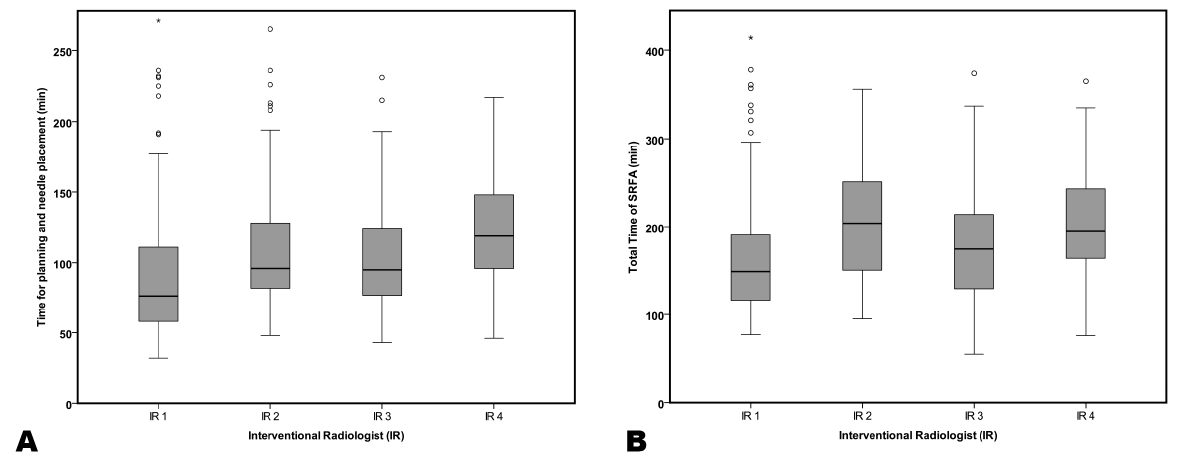
Figure 4. Boxplot comparison of time needed for ( A ) planning/placement and ( B ) the whole procedure grouped by interventional radiologists (IR). IR 1 reflects the most and IR 4 the least experienced operator.